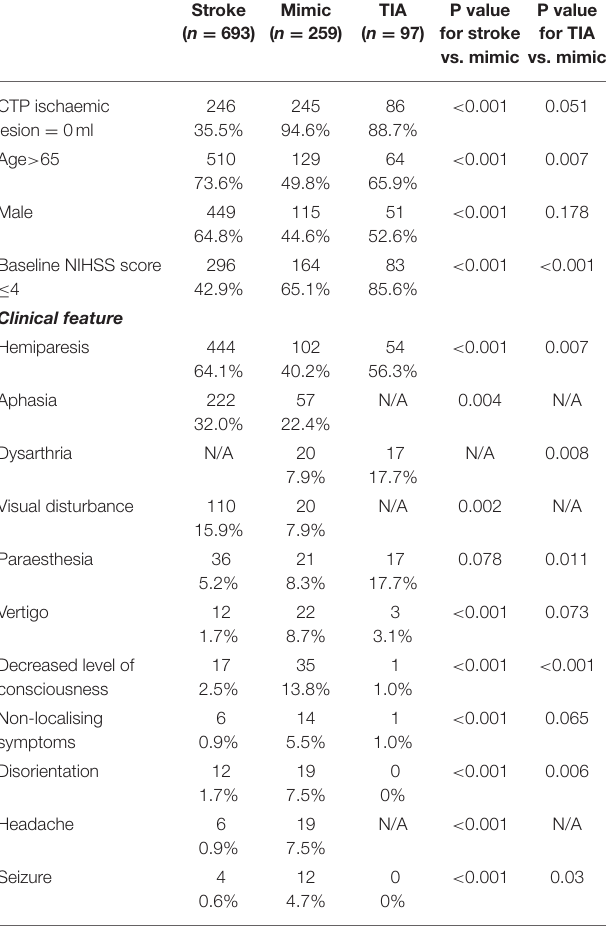
TABLE 2 | Predictors for stroke vs. mimic and TIA vs. mimic. TABLE 3 | Multivariate regression model for predicting mimic vs. stroke. Mimic vs. stroke